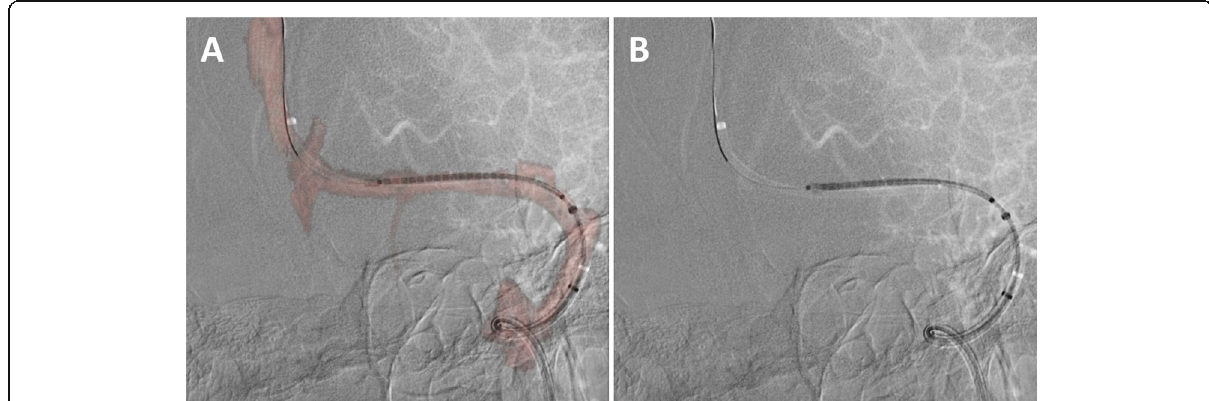
Fig. 4 Comparison of 3D MRV Fusion imaging ( a ) and 2D Conventional imaging ( b ) prior to stent